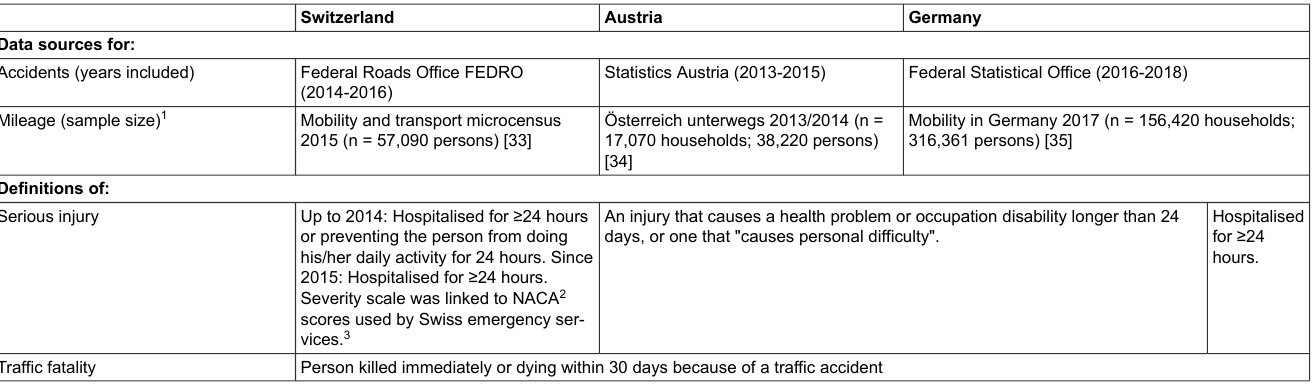
Table 1: Data sources and definitions in the three